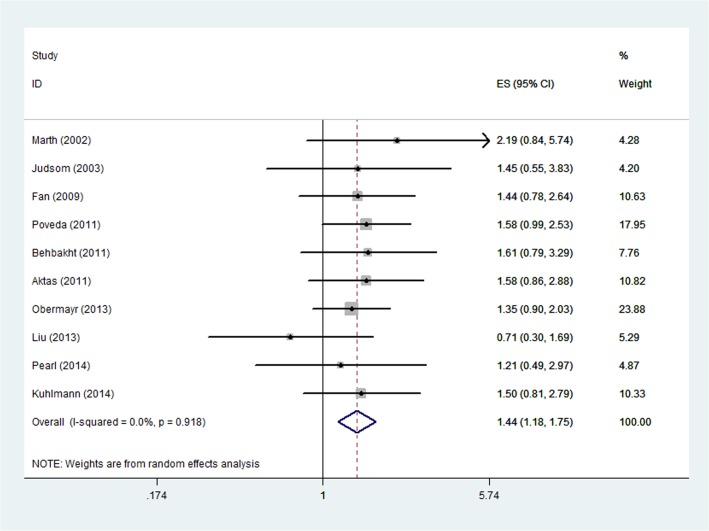
Forest plot showing the meta-analysis of hazard ratio estimates for DFS/PFS in overall patients.DFS = disease-free survival; PFS = progression-free survival.